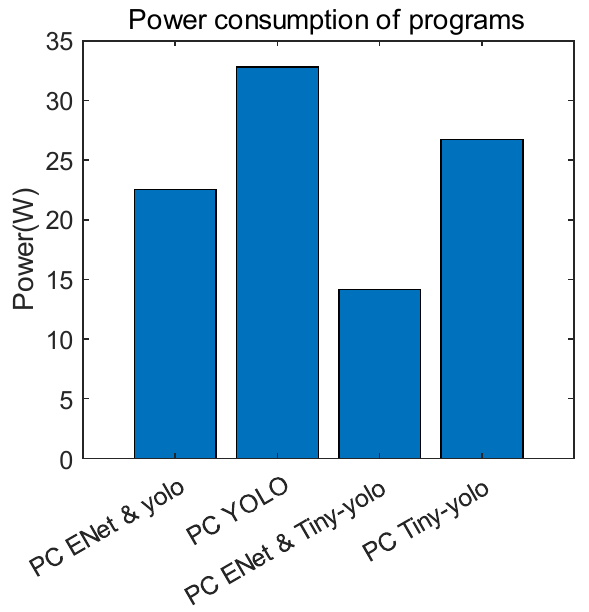
Figure 23. Power consumption results.